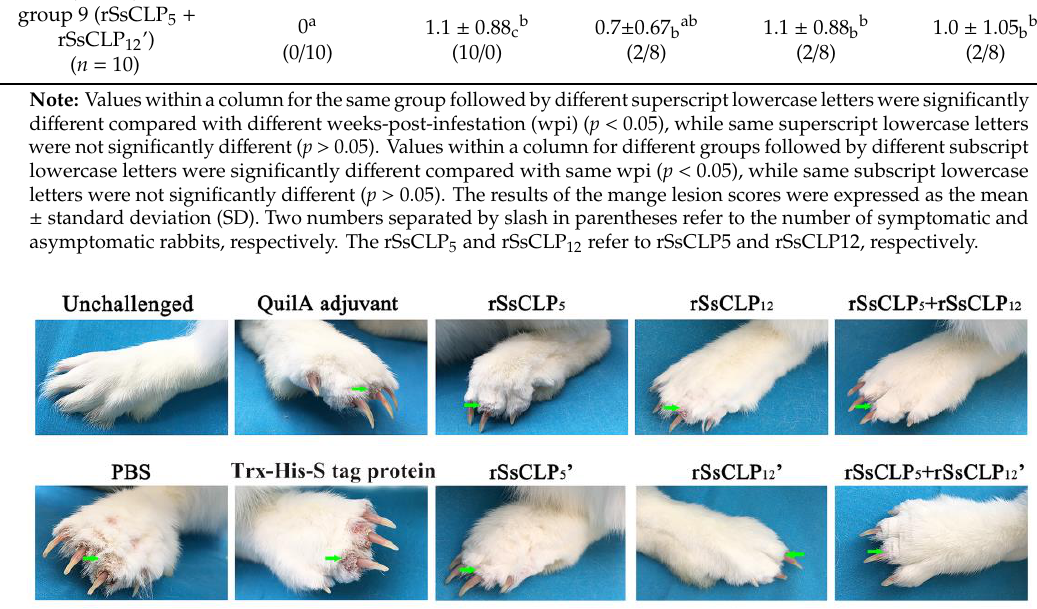
free of mite infestation; PBS, vaccinated with 1 mL 0.01 M PBS each time; QuilA adjuvant, 1 mL QuilA